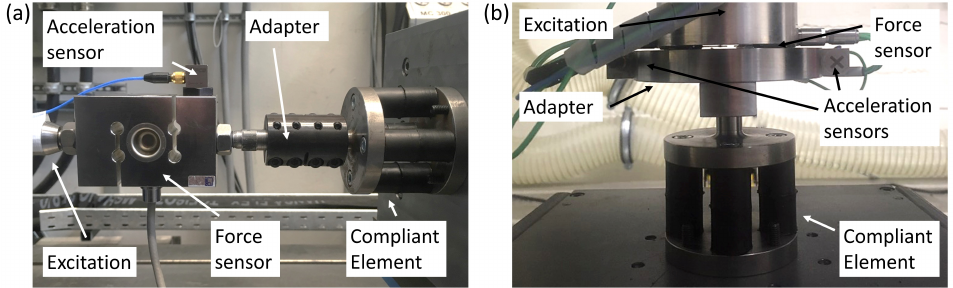
Figure 3. Test setup for the compliant element at: ( a ) low frequency; ( b ) high frequency test